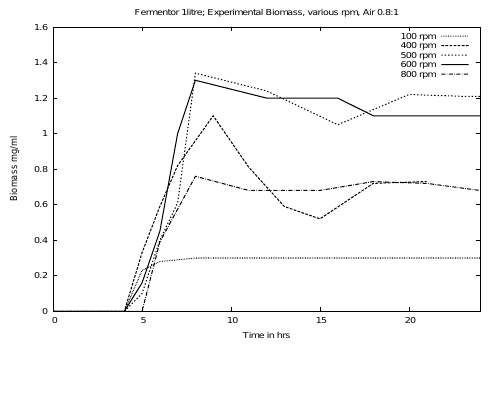
Fig. 1. Experimental biomass for different rpm